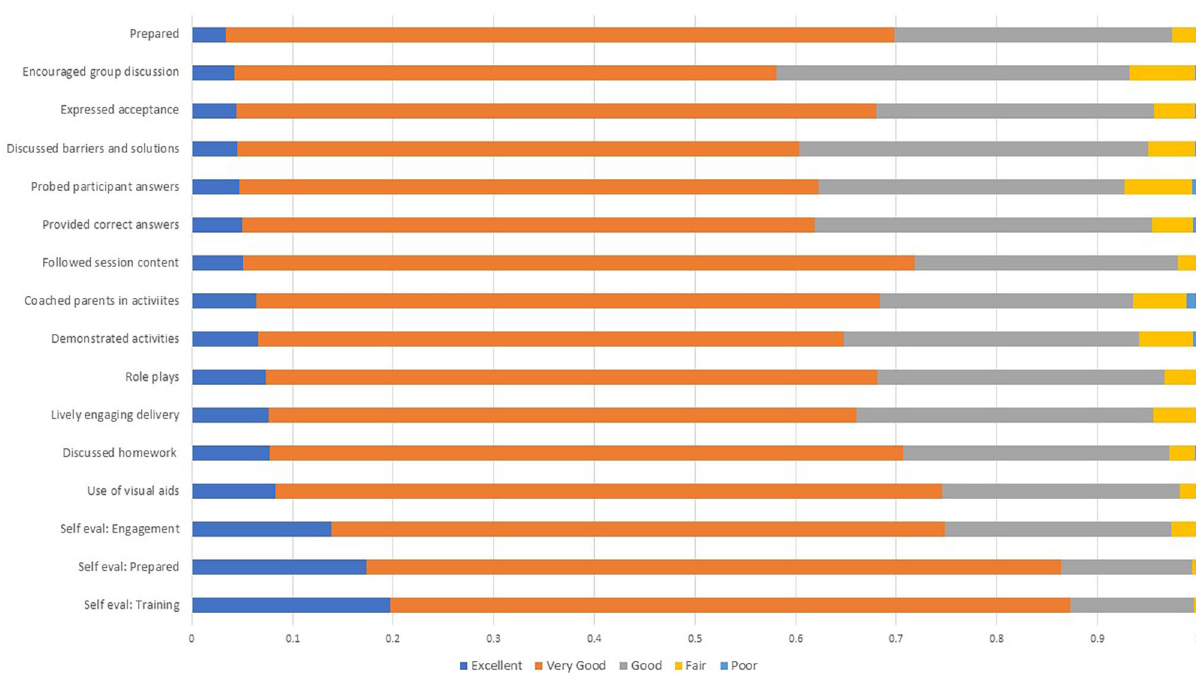
Frontiers in Public Health |